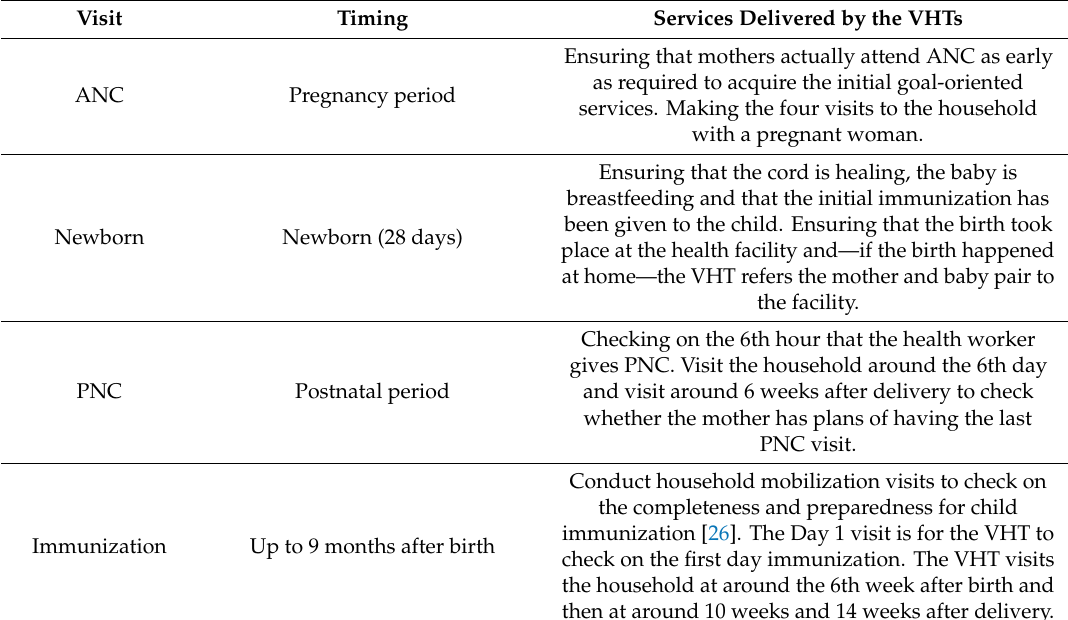
Table 2. Visits by VHTs to mothers during pregnancy or after childbirth in the control district as part of regular